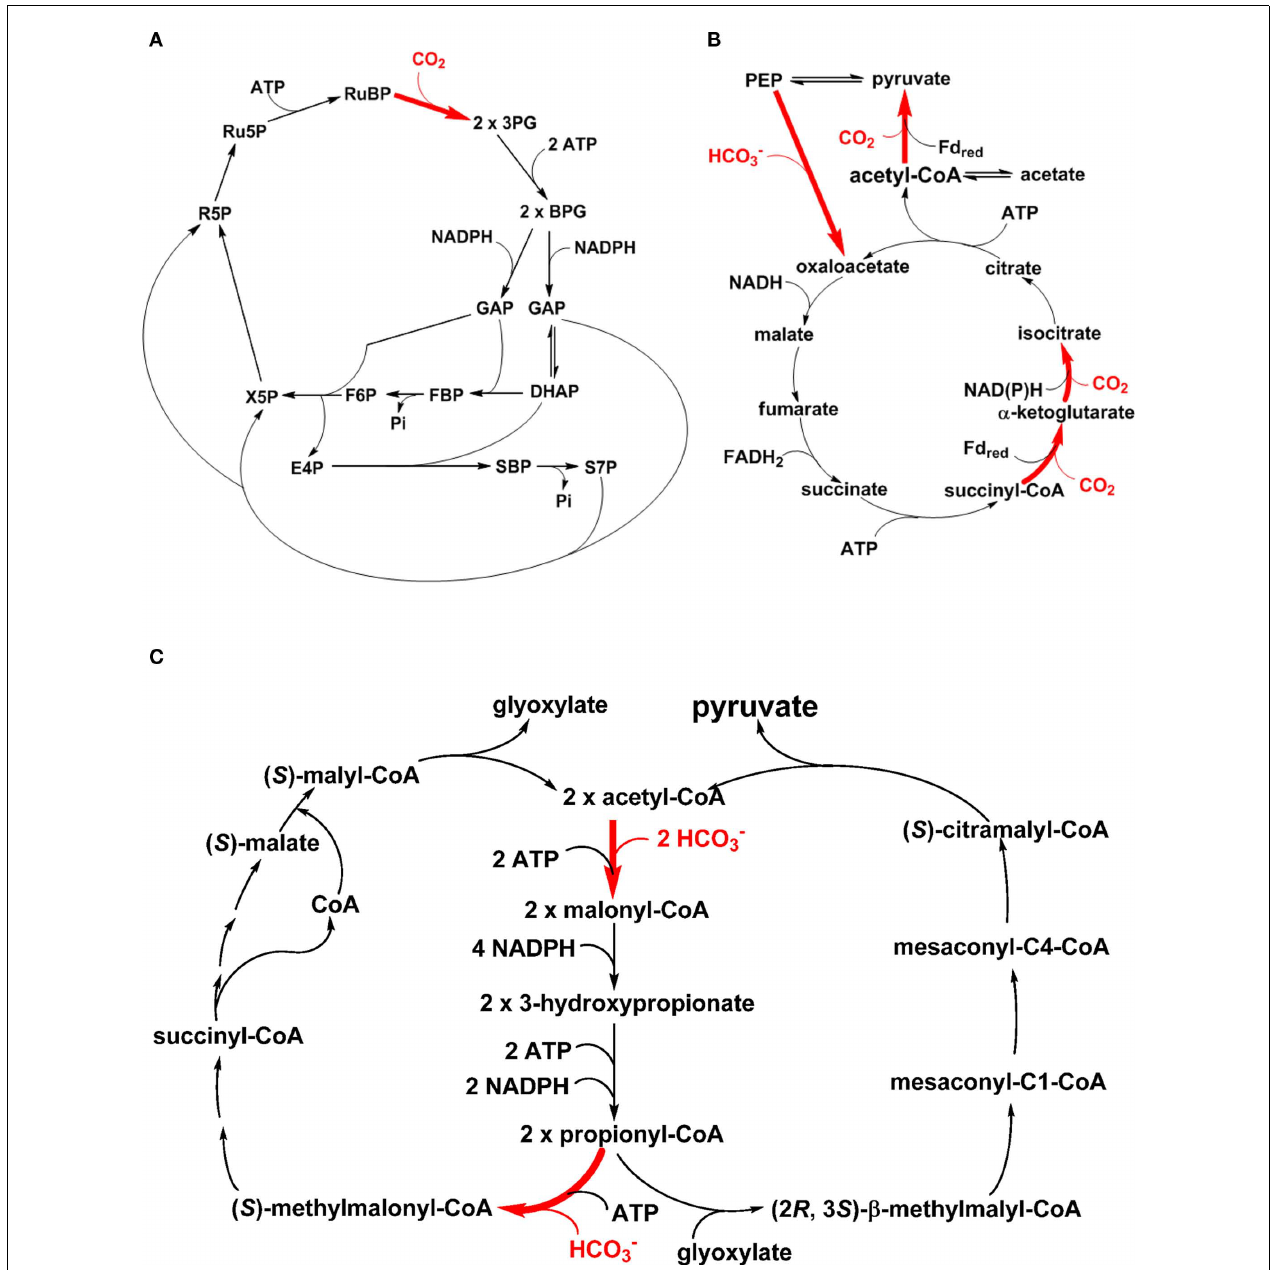
FIGURE 2 |Autotrophic CO 2 fixation pathways in phototrophic organisms. The CO 2 assimilation steps in the Calvin–Benson cycle (A) , reductiveTCA (RTCA) cycle (B) and 3-hydroxypropionate bi-cycle (C) are shown in bold and colored red. Reactions catalyzed by PEP carboxylase (i.e., the enzyme for anaplerotic CO 2 assimilation) and pyruvate synthase are included in the RTCA cycle (B) . Participations or consumption of ATP and reducing equivalents are shown.